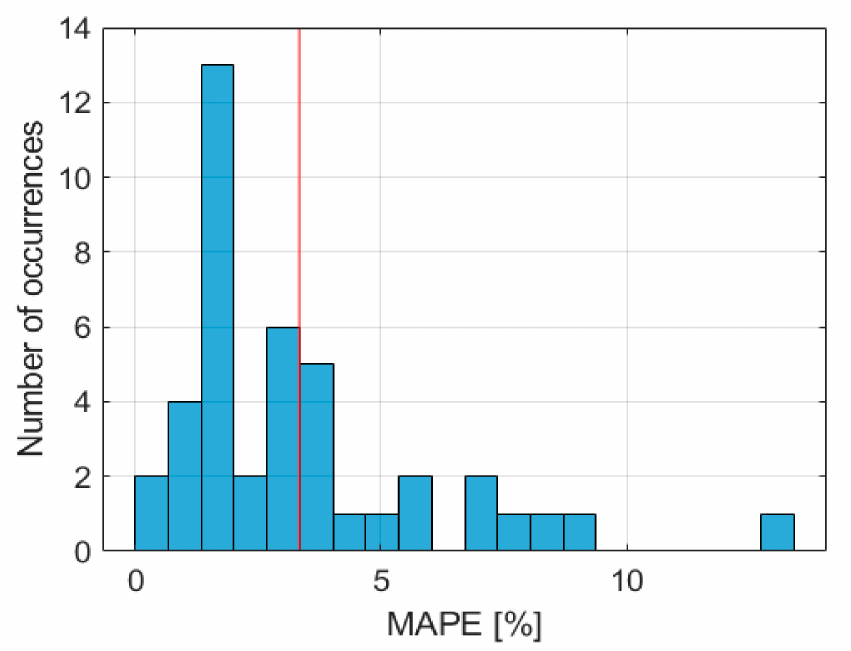
Figure 16. Distribution of the Mean Absolute Percent Error (MAPE) obtained by comparison between experimental data and simulations for 42 shots. The red line shows the average value of the